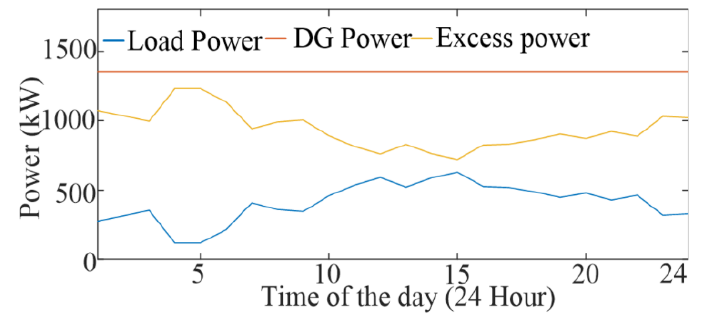
Figure 7. Power generation and consumption for one day: combination 1.